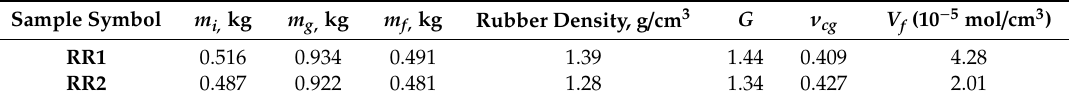
Table 4. Swelling characteristics and crosslinking density of the